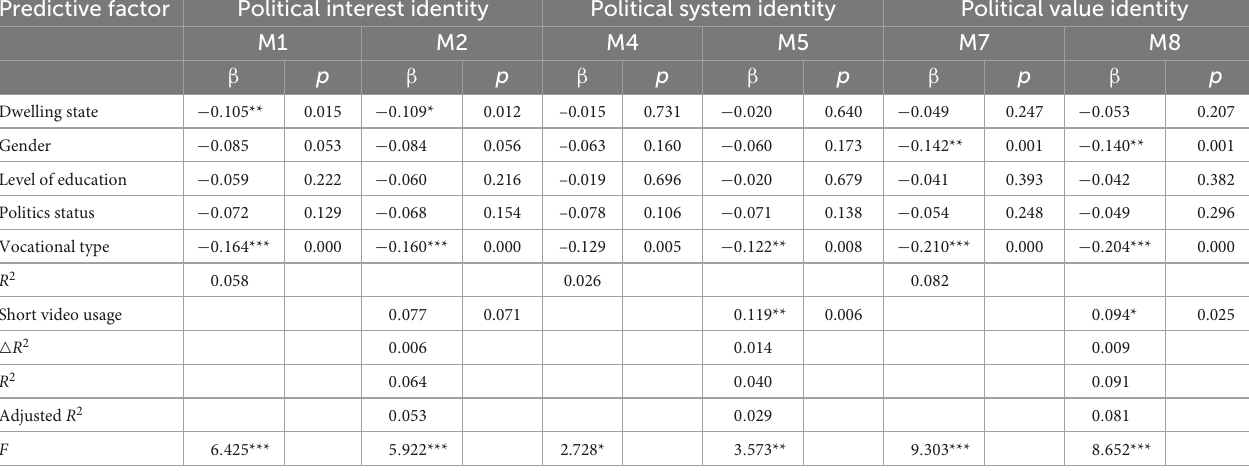
TABLE 3 Multiple regression analysis of short video use on political identity of China’s small-town youth (standard regression coefficient). Predictive factor